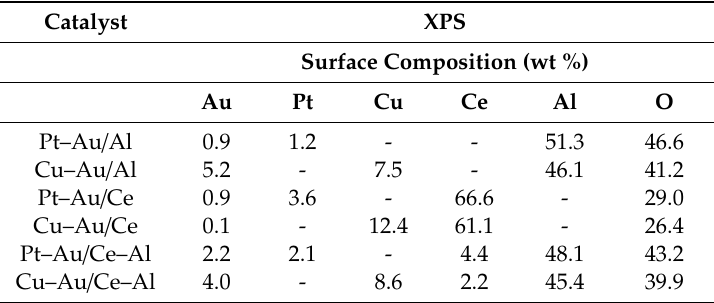
Table 3. Surface compositions of the